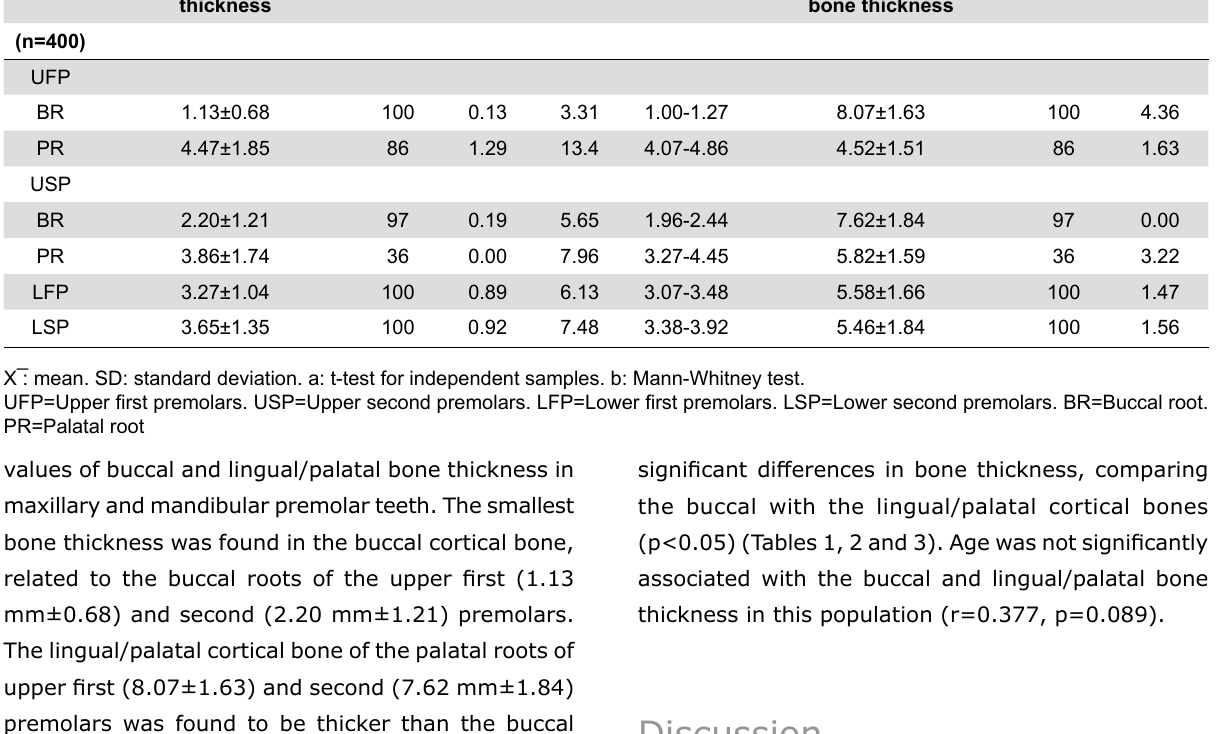
Table 2- Buccal and lingual/palatal bone thickness of maxillary and mandibular premolar teeth a,b, in the coronal Tooth